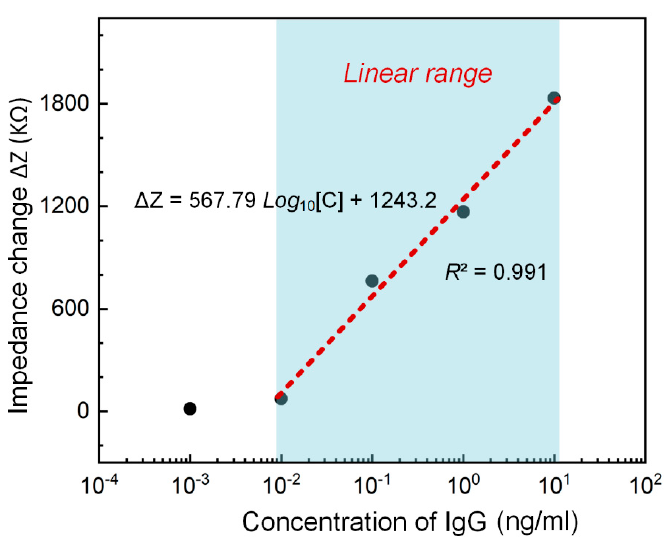
Figure 5. The response trend line of the immunosensor.